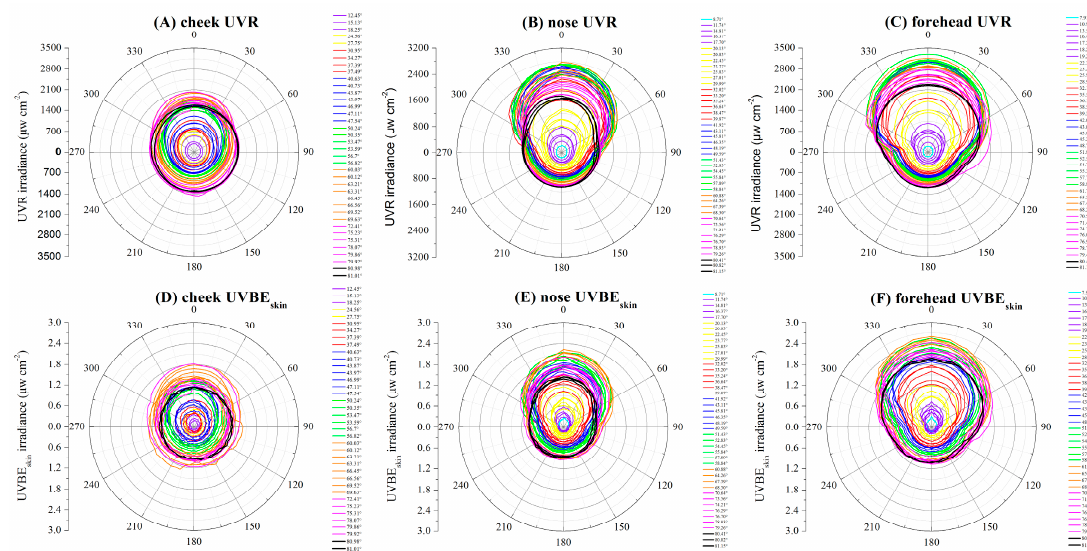
Figure 5. The UVR and UVBE skin changes with rotation angles. Notes: ( A ), ( B ), and ( C ) shows the cheek, nose, and forehead UVR changes with rotation angles, respectively. ( D ), ( E ), and ( F ) show the cheek, nose, and forehead UVBE skin changes with rotation angles, respectively.